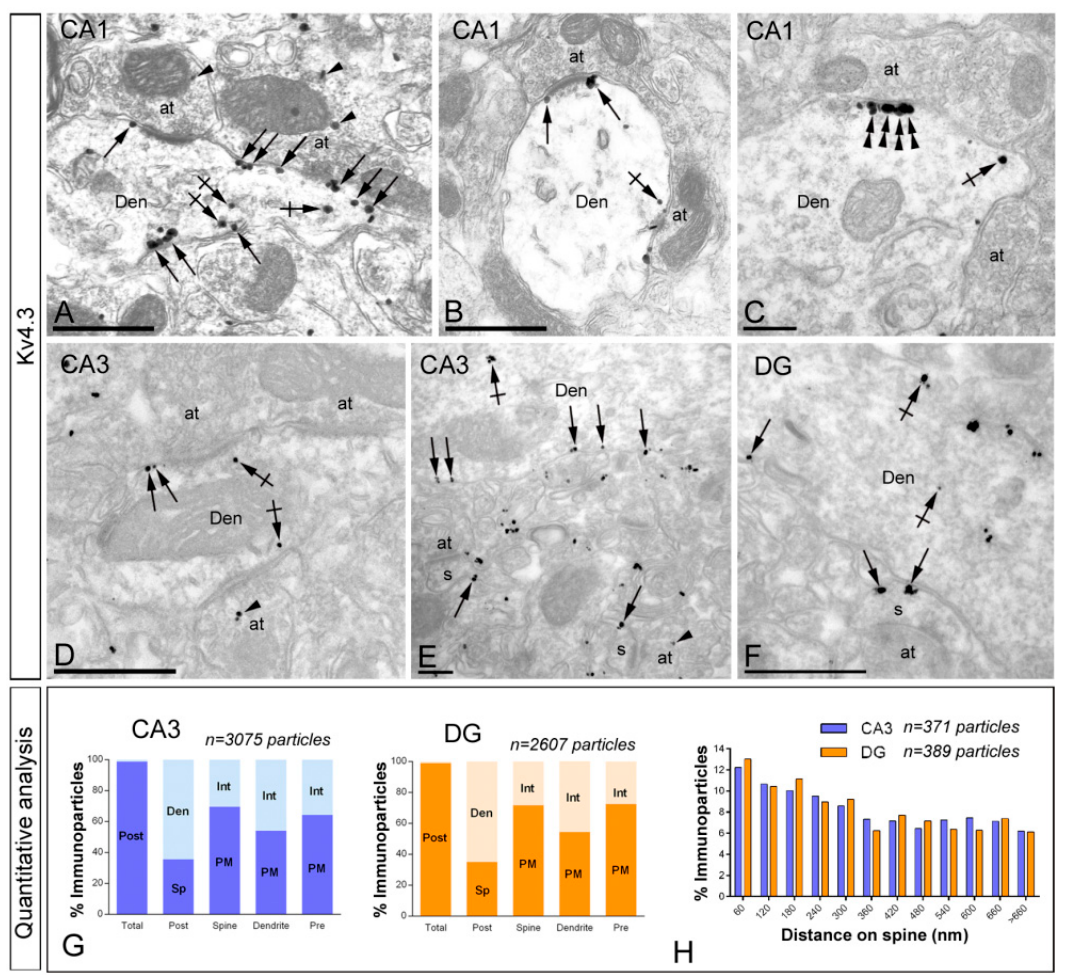
Figure 8. Subcellular localisation of Kv4.3 in the adult hippocampus. Electron micrographs showing immunoparticles for Kv4.3 in the hippocampus, as detected using the pre-embedding immunogold technique at P60. ( A – C ) In the CA1 region, immunoparticles for Kv4.3 were detected along the extrasynaptic plasma membrane (arrows) of dendritic dendritic shafts (Den) of interneurons contacted by both excitatory and inhibitory axon terminals (at) in the strata oriens and radiatum but less frequent in the stratum lacunosum-moleculare . In addition, immunoparticles were observed at cytoplasmic sites (crossed arrows) associated with intracellular membranes. Immunoparticles are present at the edge of the synaptic membrane specialisations (double arrowheads), at synapses between the dendrite (Den) of an interneuron in the stratum oriens and axon terminals (at); ( D – F ) In